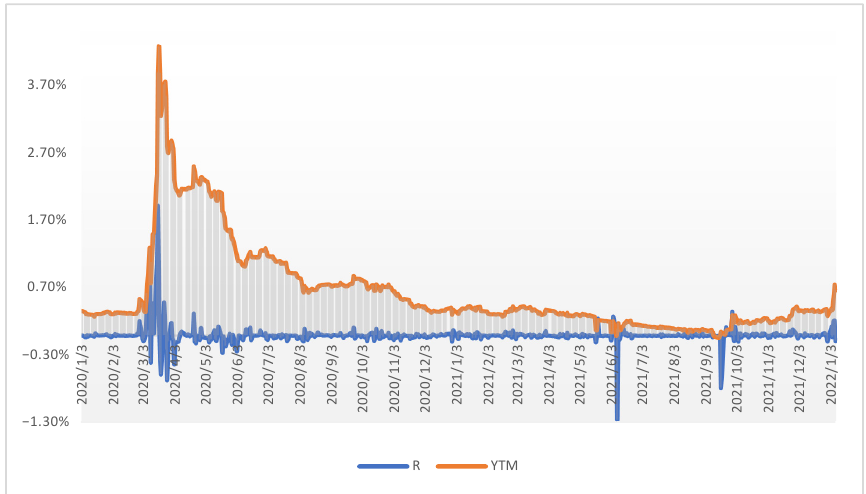
Figure 1. The volatility of the yield return and YTM of bond issue Kz18/23 from 2 January 2020 to 8 January 2022. Source: Created by the authors.